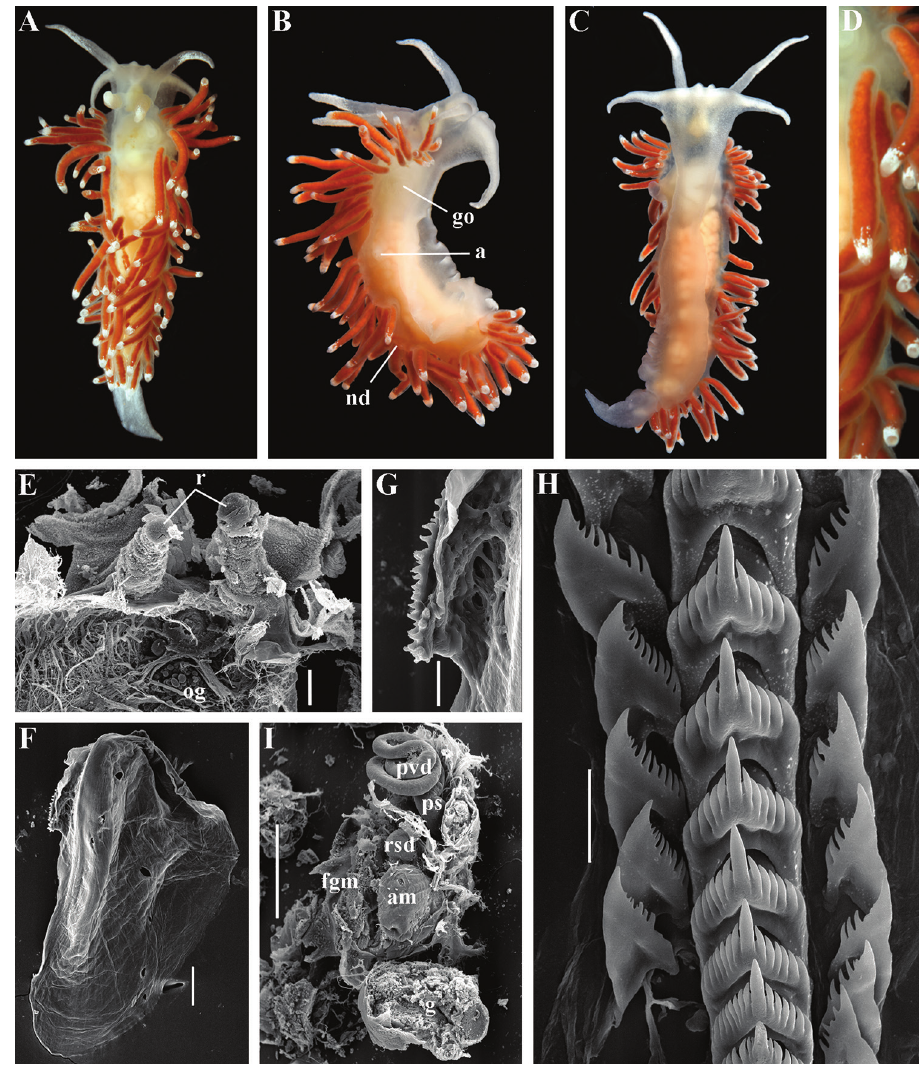
Figure 30. Microchlamylla gracilis gracilis (Alder & Hancock, 1844), comb. n. Norwegian Sea, Gulen Dive Center. ZMMU Op-502, living specimen 23 mm length: A dorsal view B lateral view C ventral view D details of cerata E dissected anterior part (pharynx removed) and rhinophores, SEM F jaw, SEM G details of masticatory process of jaw, SEM H radular teeth, posterior part, SEM I reproductive system, SEM. Abbreviations: a anus am ampulla fgm female gland mass go genital opening nd discontinuous notal edge og oral glands ps penial sheath pvd prostatic vas deferens r rhinophores rsd distal recep- taculum seminis. Scale bars: E, I = 1 mm; F = 300 μm; G, H = 30 μm. Photos and SEM images by T.A. Korshunova, A.V.